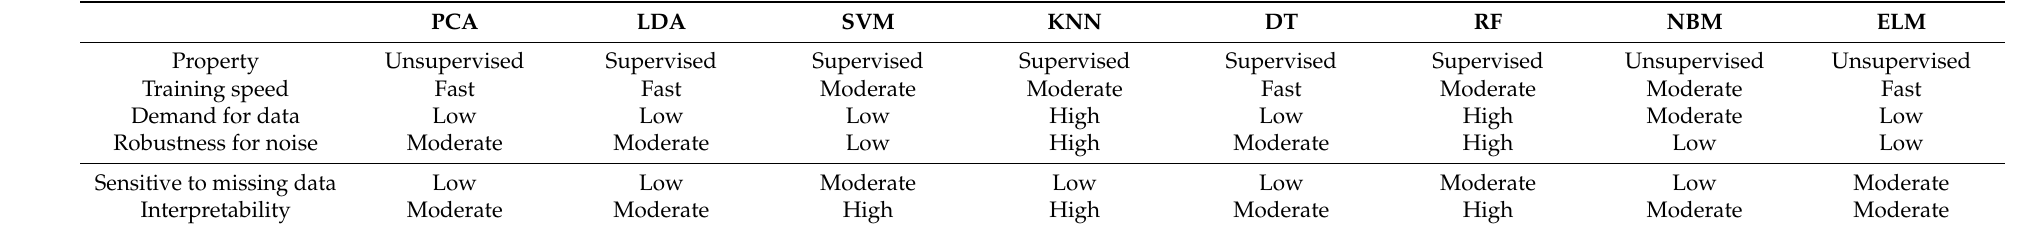
Table 1. Comparison of the classical traditional gas identification